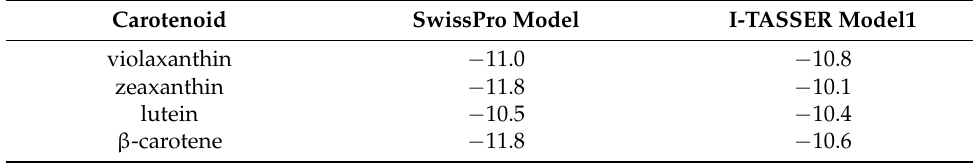
Figure 6. ( A ) Cellular Localization of V5-tagged mouse BCO2 with and without lutein: mBCO2 with and without 0.15 µ M lutein; (left panel) mBCO2 with and without 0.06 µ M lutein; (right panel). Pearson’s correlation coefficients were calculated for colocalization of V5-tagged mBCO2 protein with nucleus ( B ). Table 1. AutoDock Vina modeling of the affinity of carotenoids to mBCO2. The lowest (best) docking energy is